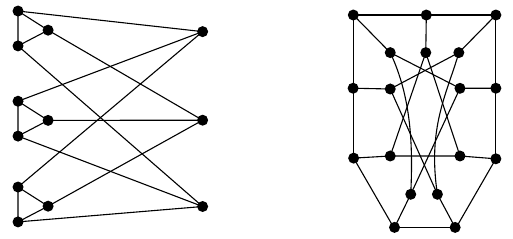
Fig. 7: The only two Type 2 square-free cubic graphs of order up to 32. The first one is the graph obtained from K 3 , 3 by replacing all vertices of one set of the bipartition by triangles, and the second one is the generalized Petersen graph P (9 , 3)